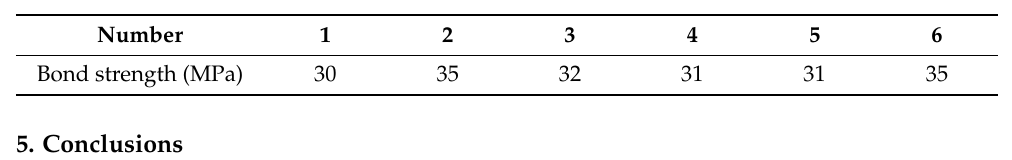
Figure 12. The fracture morphology of the coating after the bonding strength tests: ( a ) the macro fracture morphology; ( b ) the microscopic diagram of the fracture interface. Table 4. Bond strength of the Ti/Ti/HA coating.